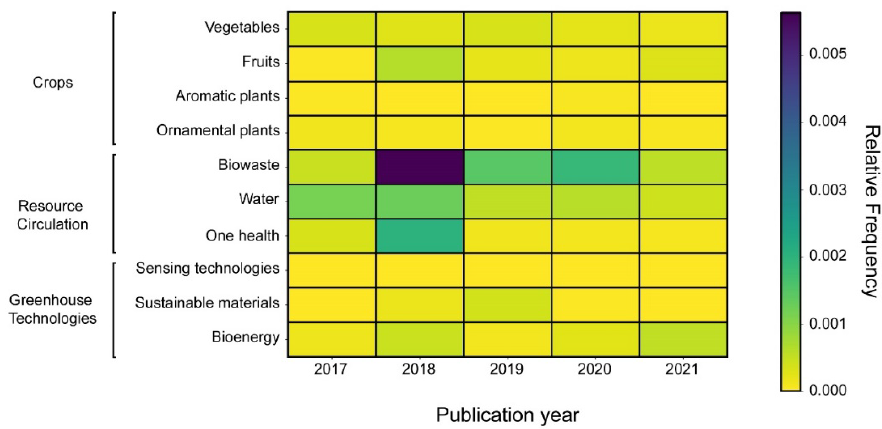
Figure 7. Trends in circular horticulture research topics—own